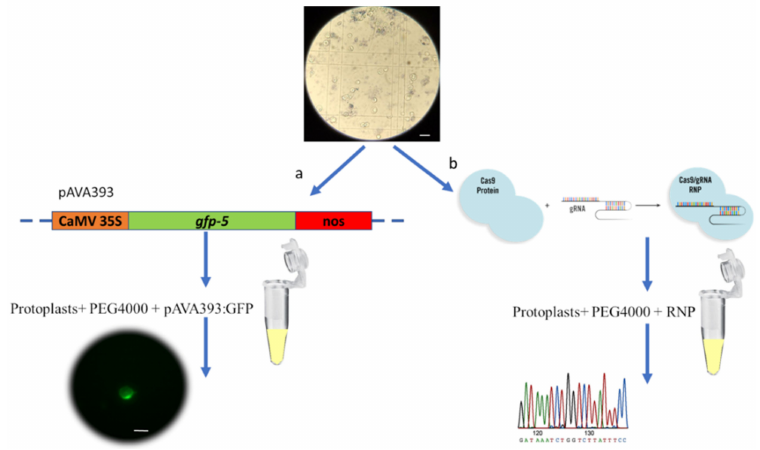
Figure 5. PEG-mediated transfection protocol. ( a ) Protoplast transfection using GFP marker gene and subsequent visualization using the Nikon Eclipse Ti2 fluorescent microscope. ( b ) Protoplast transfection using RNP complex by targeting the pds gene, followed by DNA extraction and Sanger sequencing. Scale bar = 100 µ m.